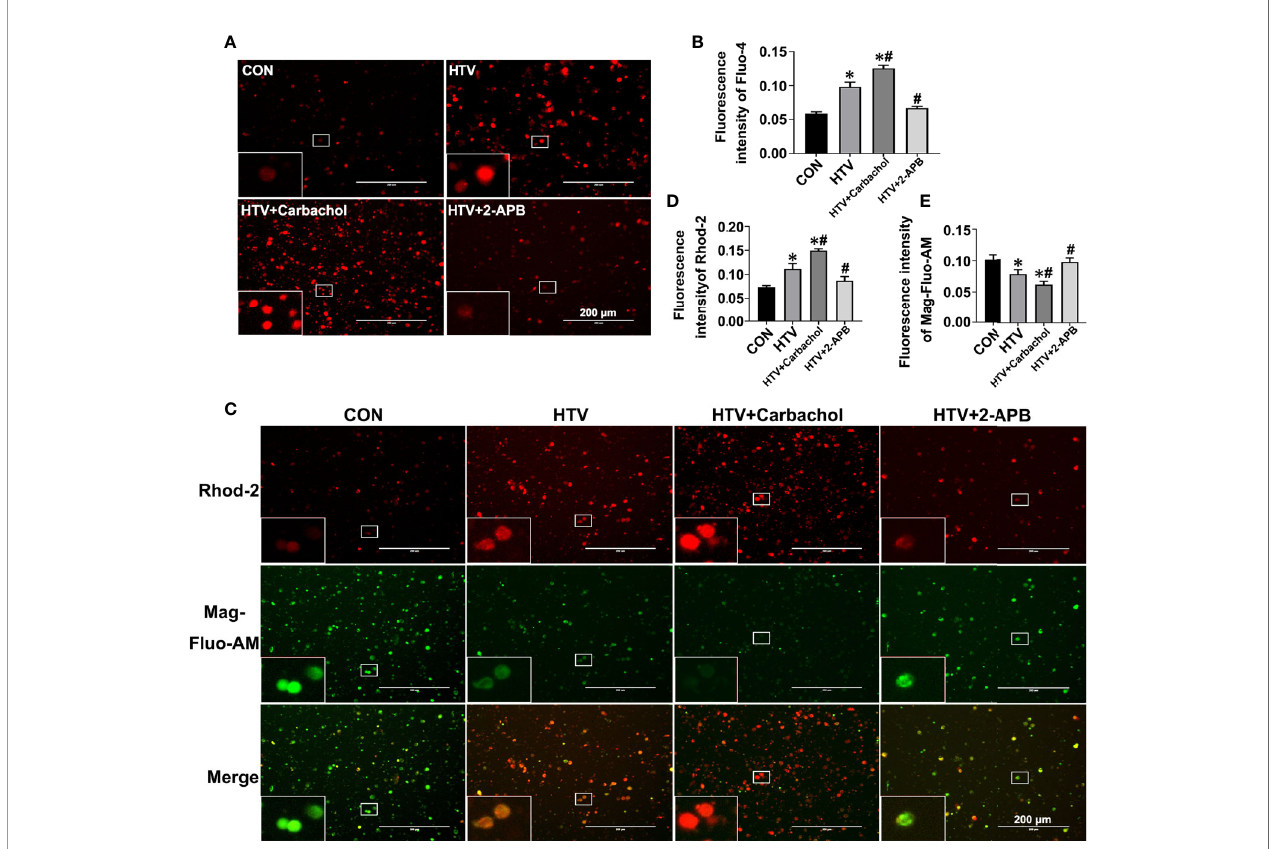
FIGURE 3 | Effects of carbachol and 2-APB on HTV-induced Ca2+ homeostasis in lungs. Single-cell suspensions from lung tissues were preloaded with Fluo-4 AM, Rhod-2 and Mag-Fluo-AM, respectively. (A) Fluo-4 AM labeling the cytoplasmic Ca2+ in lung tissues from CON group, HTV group, IP3R agonist carbachol pretreatment upon HTV stimulation group (HTV+Carbachol group) and IP3R inhibitor 2-APB pretreatment upon HTV stimulation group (HTV+2-APB group). An inset picture was employed to show the indicated area at 4X magni fi cation. (B) Fluorescence quanti fi cation analysis of Fluo-4 AM. (C) Rhod-2 and Mag-Fluo-AM co- dyeing to label Ca2+ in the mitochondria and ER in different groups. An inset picture was employed to show the indicated area at 4X magni fi cation. (D) Fluorescence quanti fi cation analysis of Rhod-2. (E) Fluorescence quanti fi cation analysis of Mag-Fluo-AM. Data are expressed as means ± SD (n = 6 per group). *P < 0.05 vs . CON group; # P < 0.05 vs . HTV